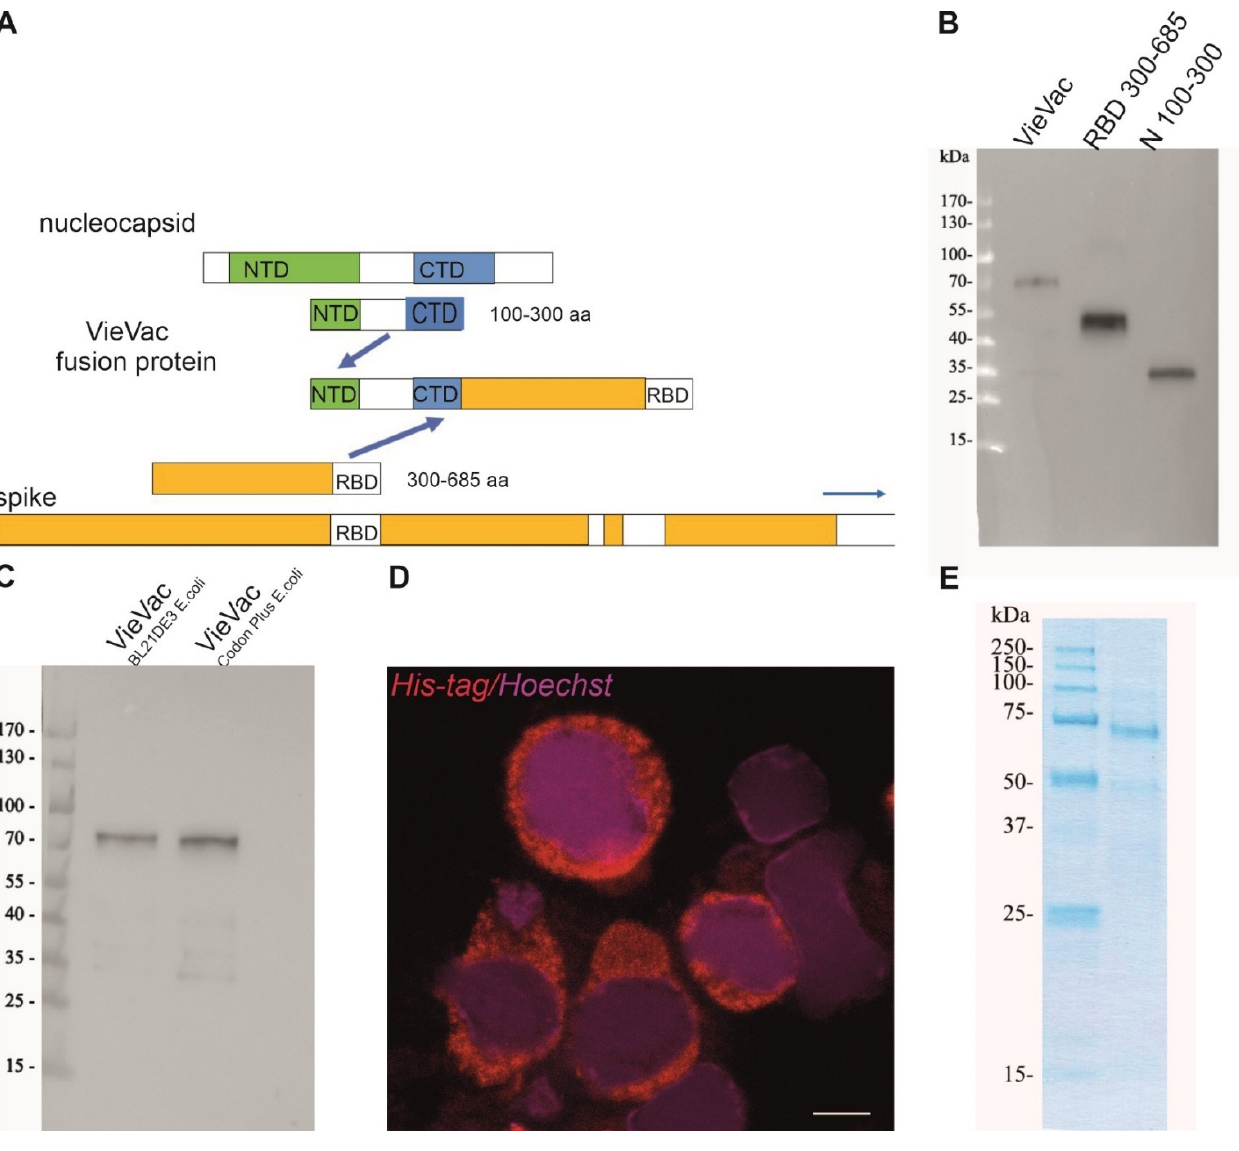
Figure 1. Expression construct and biochemical characterization of purified proteins. ( A ) Scheme of fusion protein design. The immunodominant region N100–300 aa of the nucleocapsid and S300–685 aa of the spike protein were fused, and the product (termed ‘VieVac’) was engineered into either the pET-30a E. coli expression vector or a baculovirus. ( B ) Protein immunoblot of E. coli -produced ‘VieVac’ fusion protein and its constituents using convalescent serum. The fusion protein (‘VieVac’, lane 1), S300–685 aa (lane 2) and N100–300 aa of the nucleocapsid protein (lane 3). Molecular weight marker is shown to the left. ( C ) Protein immunoblot of E. coli -produced fusion proteins ‘VieVac’ using mouse immune serum. The fusion proteins were purified out of E. coli lysate through their His-tag. VieVac produced in E. coli BL21DE3 (lane 1), and ‘VieVac’ produced in E. coli BL21Codon Plus (lane 2). ( D ) Immunofluorescence staining of Hi5 cells using anti-His.H8 mAb to detect ‘VieVac’ (red) in cells infected with baculovirus. Scale bar = 10 µm. ( E ) Protein staining of insect-cell-produced fusion protein ‘VieVac’. The fusion protein was purified through its His-tag out of Hi5 lysate results, with the full-size protein migrating at 72 kDa with only minor degradation products (lane 2). Molecular weight markers are shown to the left (lane 1).